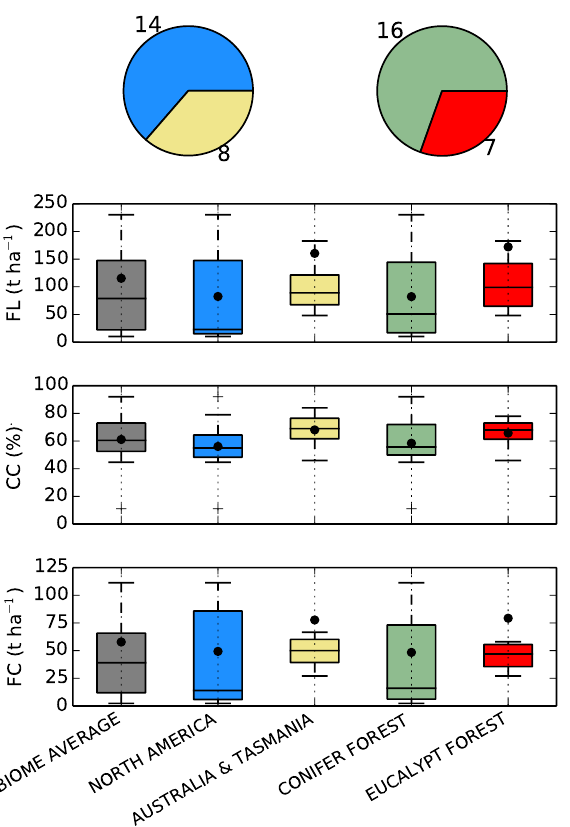
Figure 5. Overview of field measurements of fuel load (FL), com- bustion completeness (CC), and fuel consumption (FC) in the bo- real forest biome. The pie charts on top correspond to the number of unique measurement locations for different geographical regions (left) and fuel classes (right), and in the box plots below field aver- ages of FL, CC, and FC are presented. The boxes extend from the lower to upper quartile values of the measurement data, with a line at the median and a black filled circle at the mean. The whiskers extend from the box to show the range of the data, and outliers are indicated with